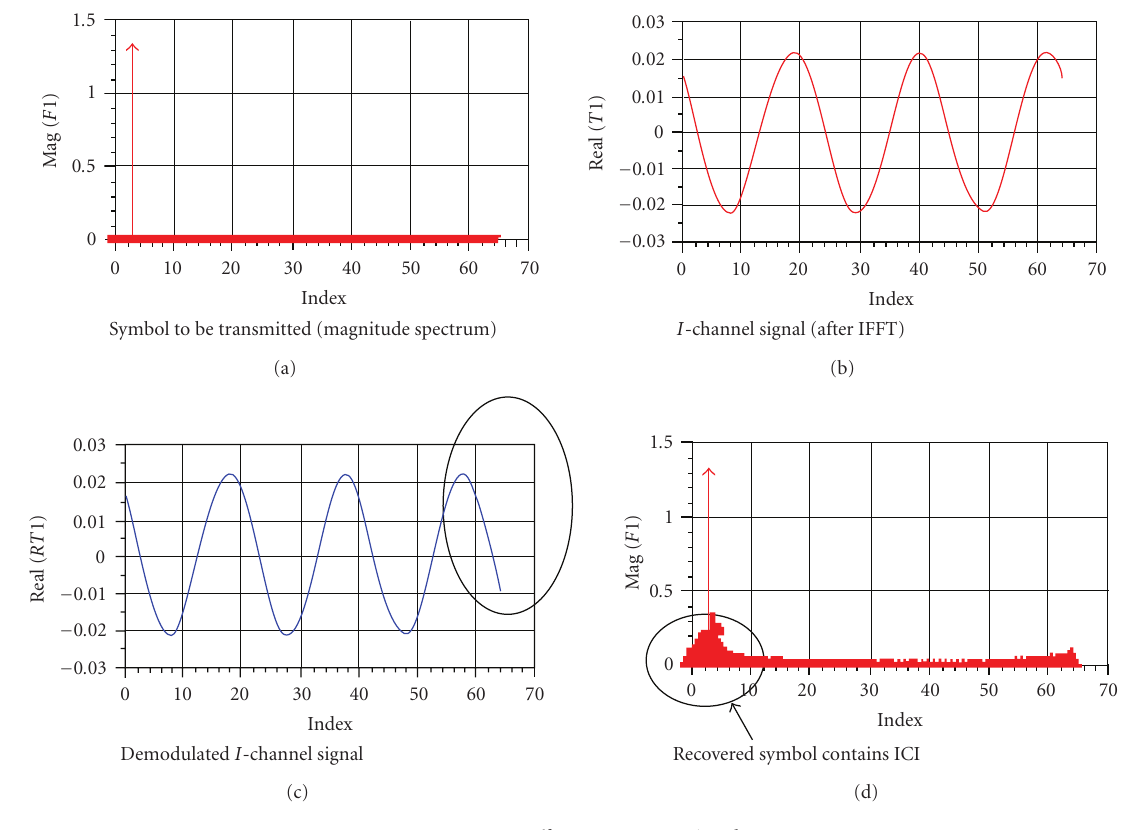
Figure 2: ICI e ff ects on OFDM